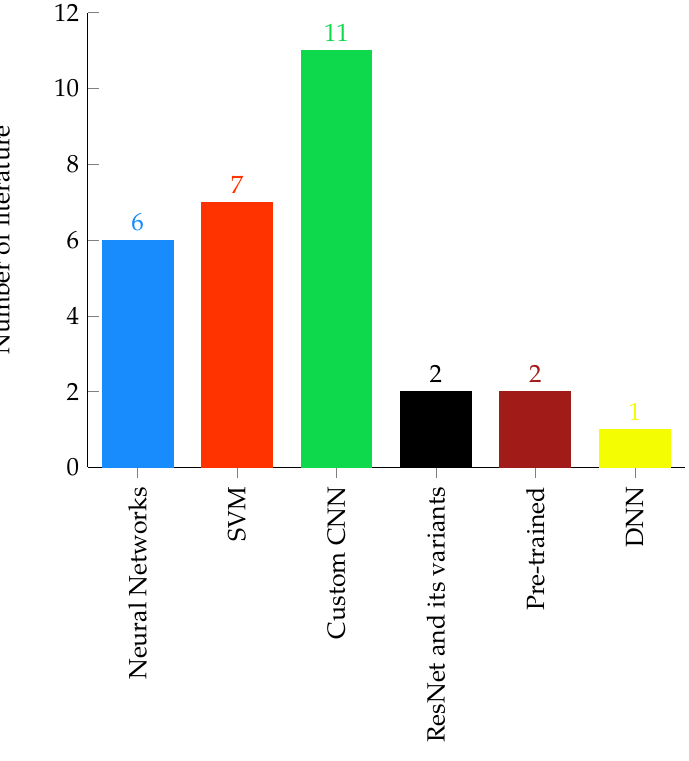
Figure 2. Number of brain tumor classification